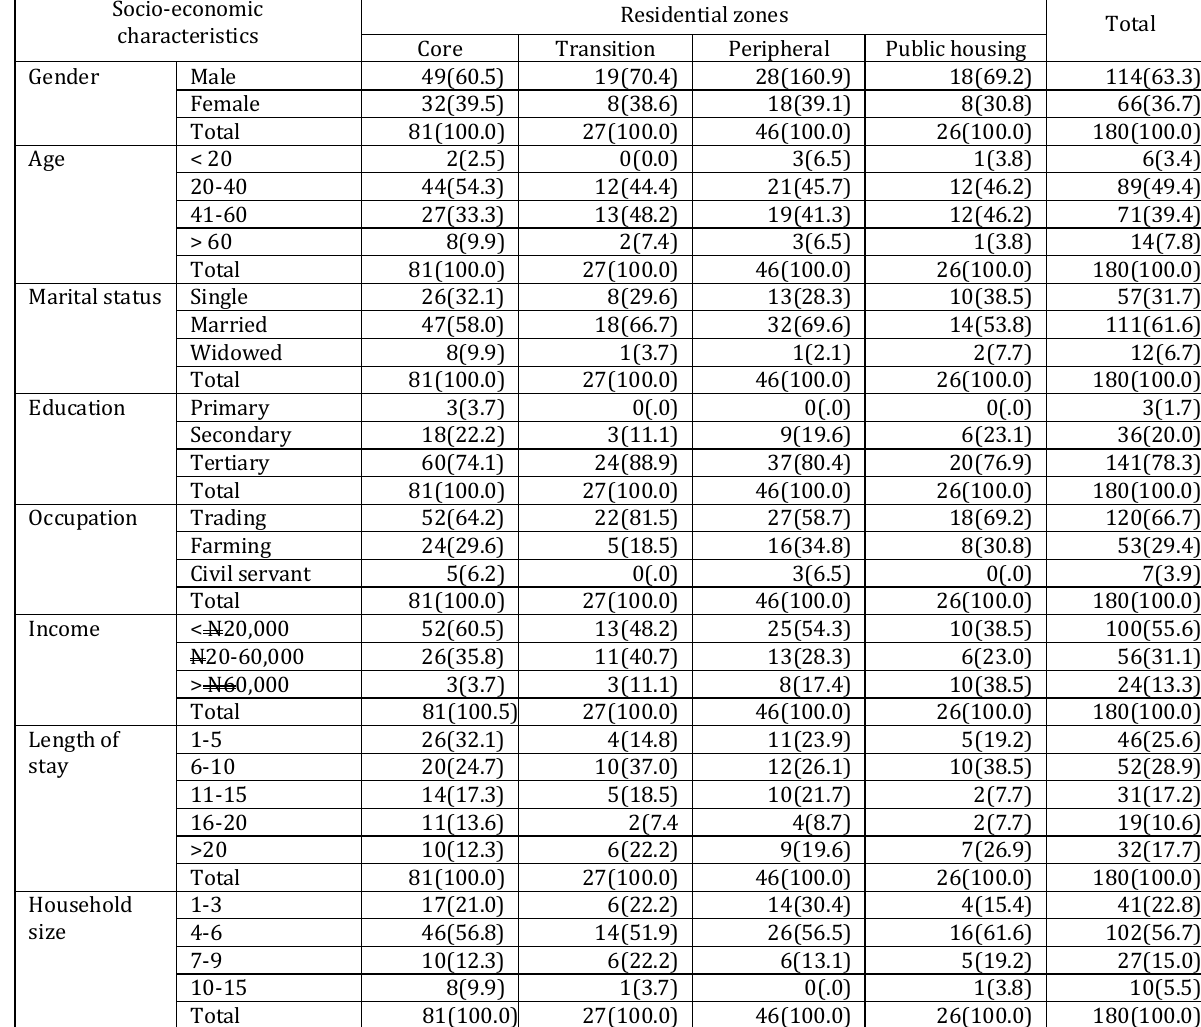
Table 2. Socio-economic characteristics of